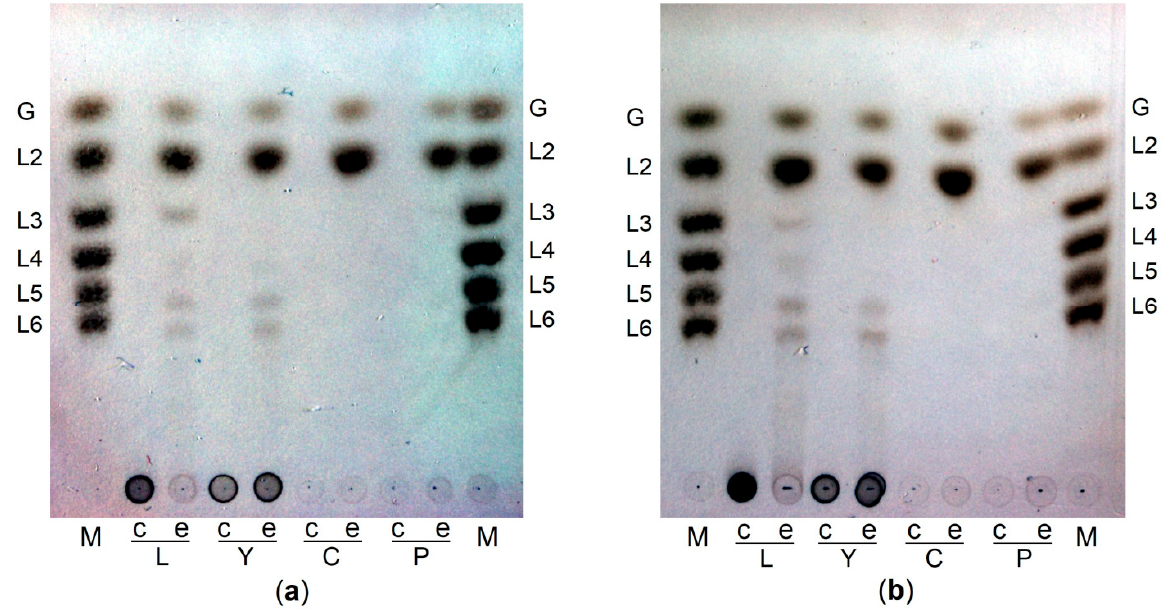
Figure 4. TLC analysis of hydrolysis products. Hydrolysis of laminarin (L), yeast β -glucan (Y), curdlan (C), and pachyman (P) by PsLam81A ( a ) and PsLam81A Δ CBM56 ( b ). Carbohydrate standards (M): glucose (G), laminaribiose (L2), laminaritriose (L3), laminaritetraose (L4), laminaripentaose (L5) and laminarihexaose (L6). Reactions were carried out in the presence (e) and absence (c) of the enzyme.